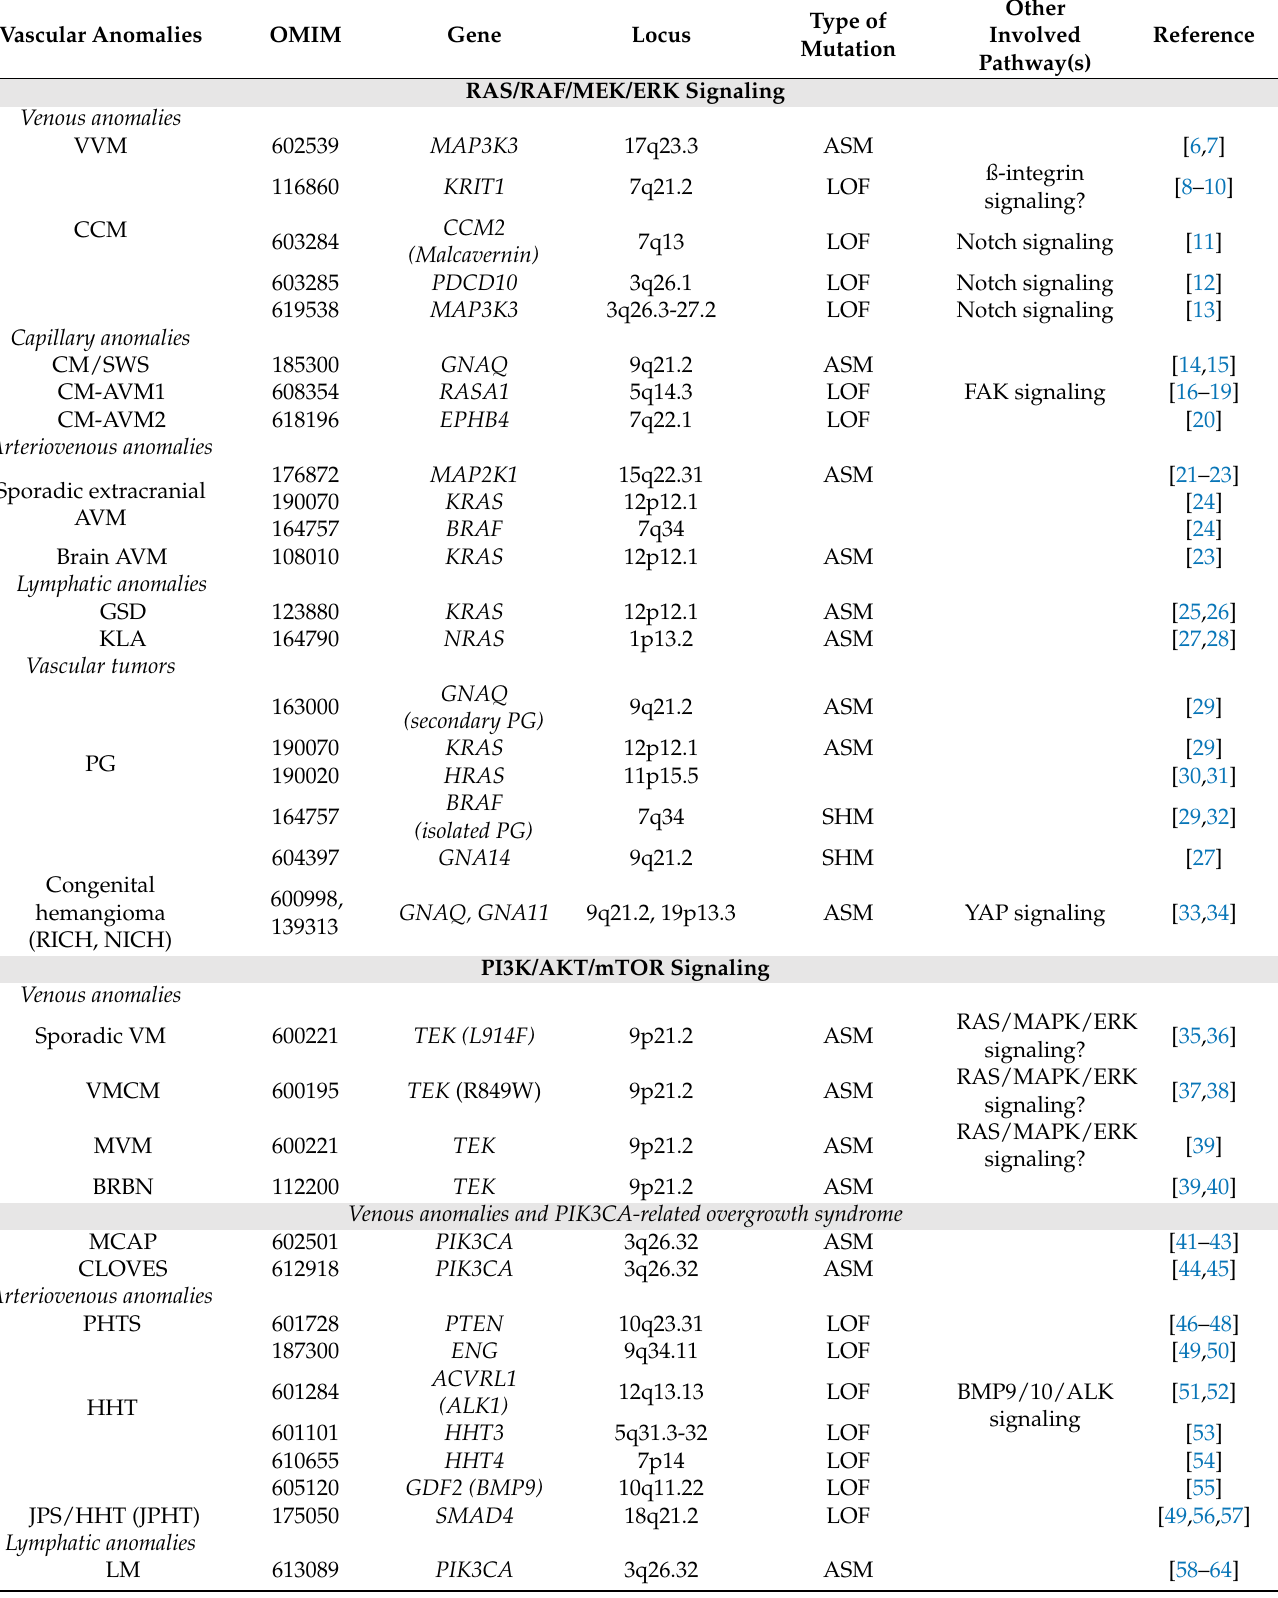
Table 2. The Molecular Pathophysiology of Vascular Anomalies: Genes/Loci and Signaling